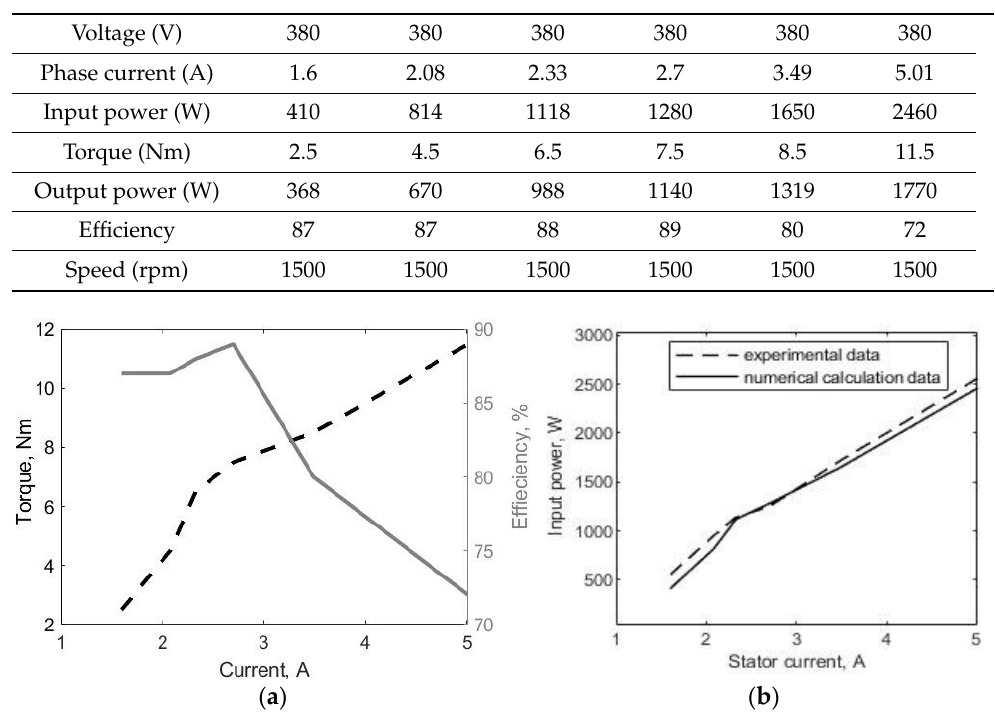
Figure 8. Experimental setup for motor testing. Table 6. Load test result of the SynRM AT 1500 RPM.